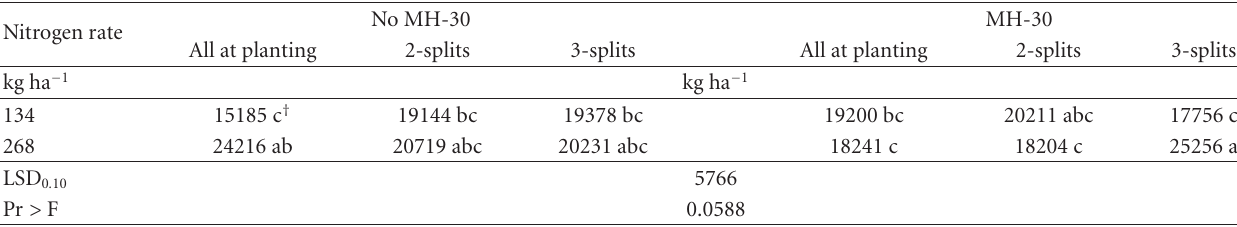
Table 6: Nitrogen rate × N application timing × MH-30 interaction in 2010 for total yield for Russet potatoes grown on sandy loam soils in the Mid-Atlantic.